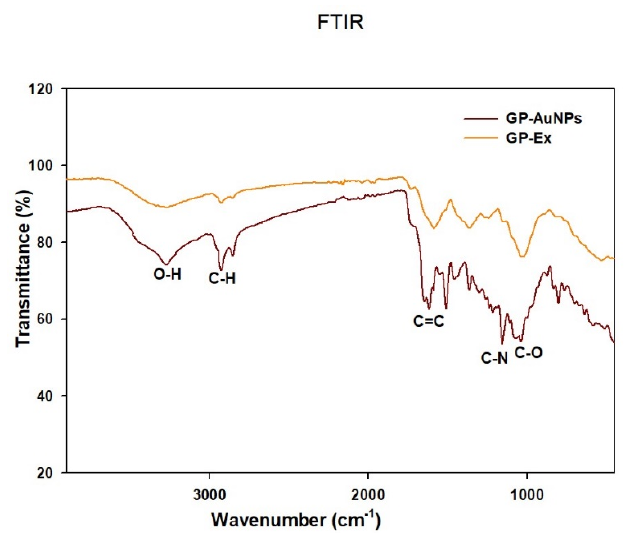
Figure 4. FTIR analysis of synthesized GP-AuNPs and GP-Ex .